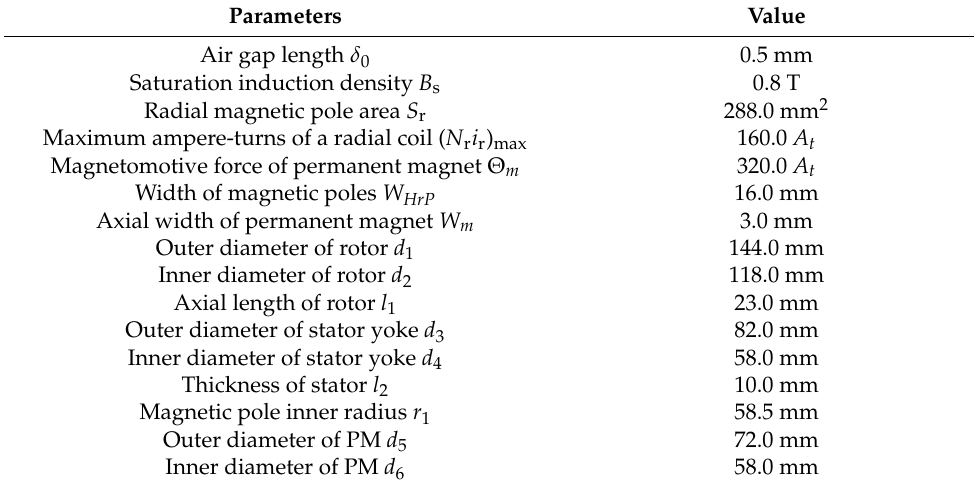
Table 1. Prototype Parameters.